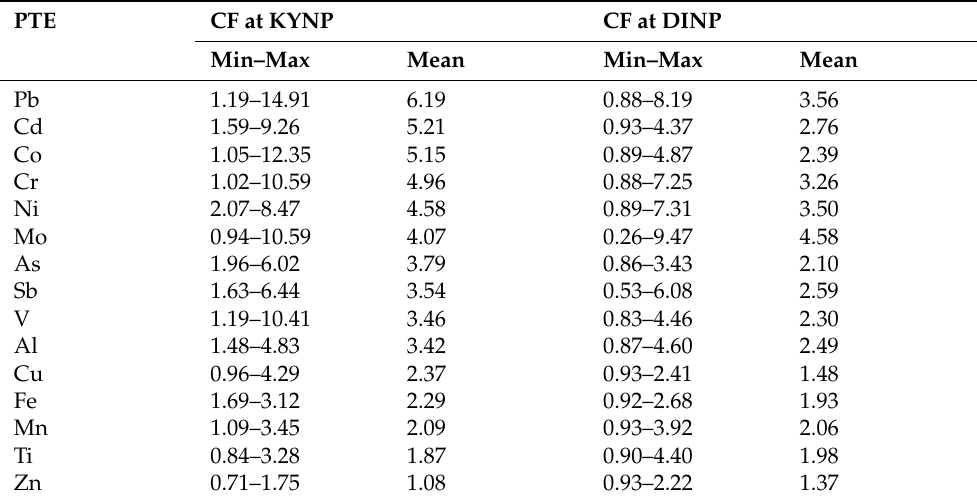
Table 4. Range of the contamination factor (CF) of each potentially toxic elements (PTE) from all monitoring sites.